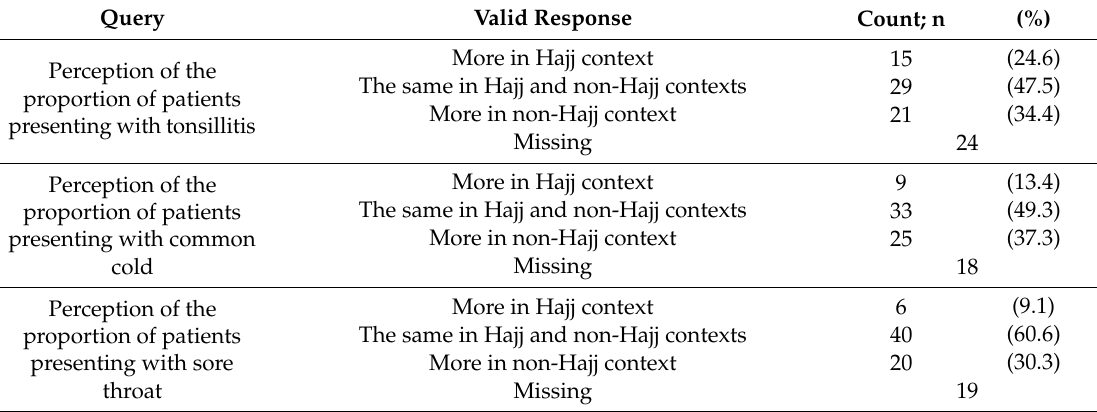
Table 3. Knowledge and perceptions of Hajj deployed healthcare workers regarding upper respiratory tract infections (URTIs) and related treatment